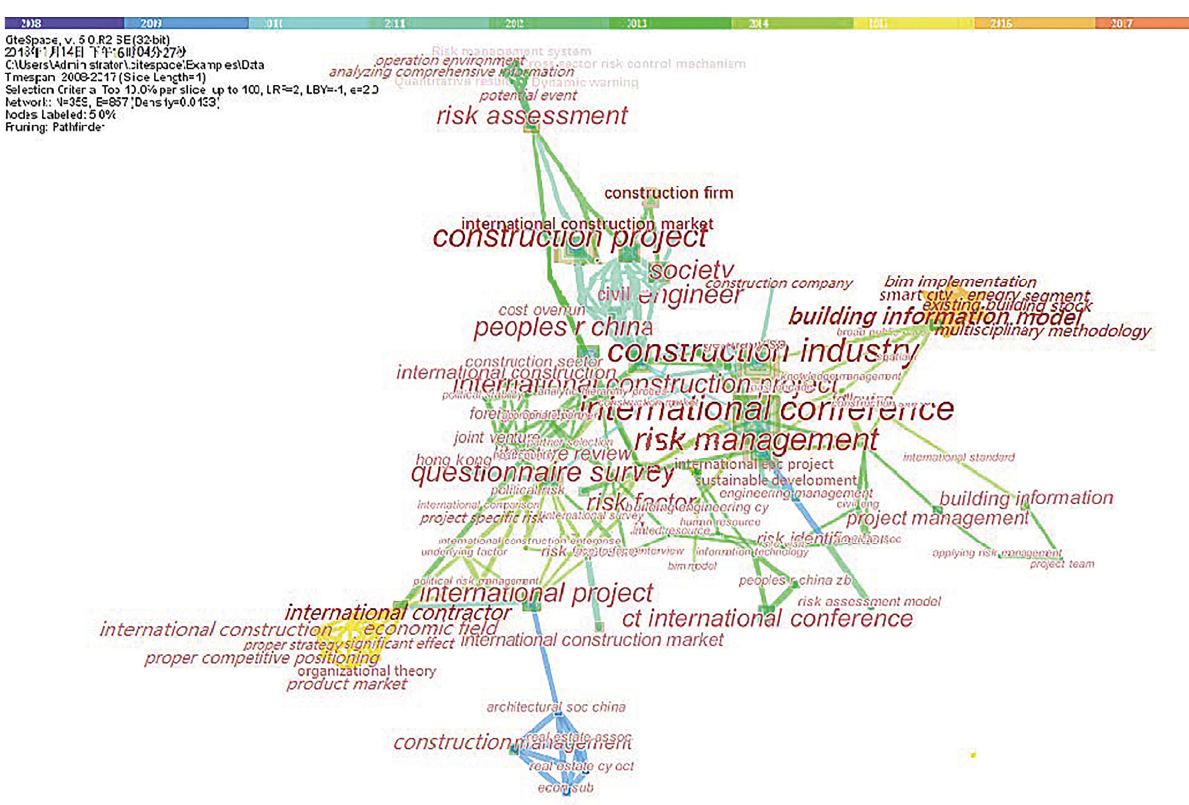
Figure 3: Keyword cooccurrence